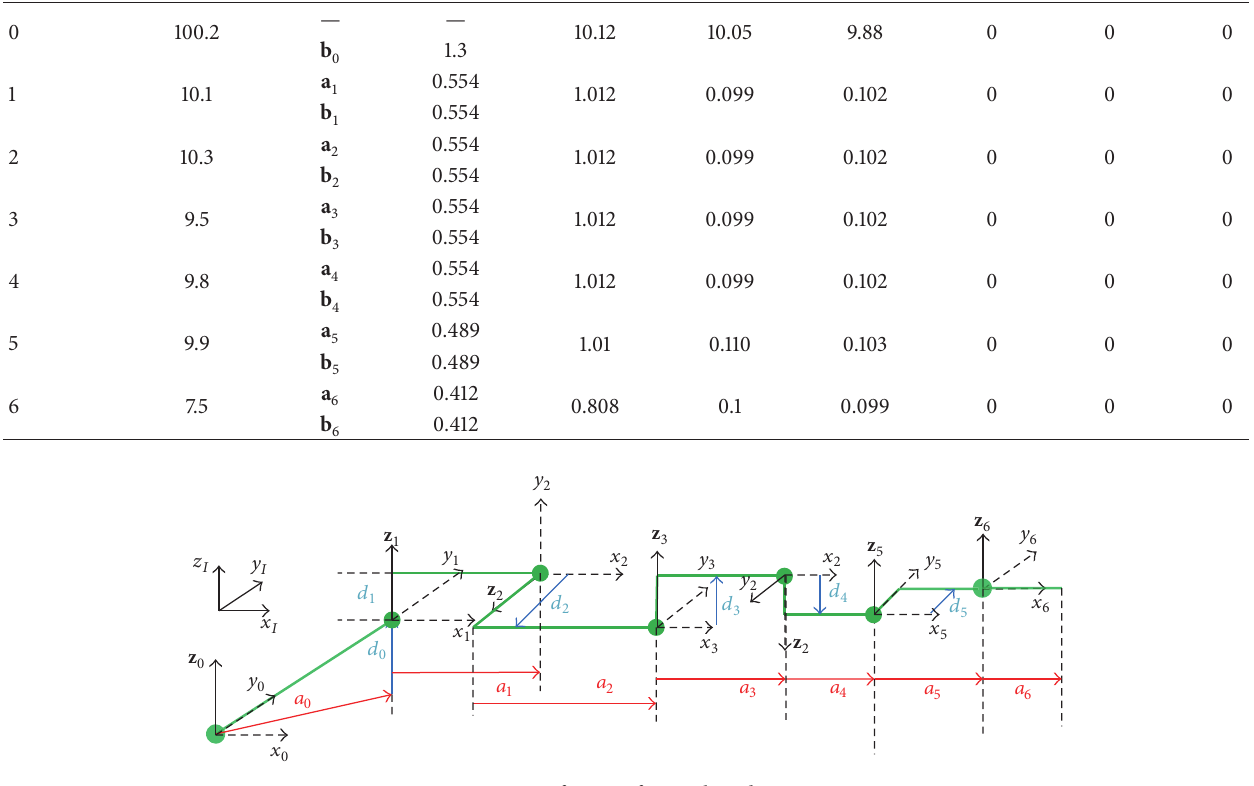
Figure 4: D-H frames of space-based systems.